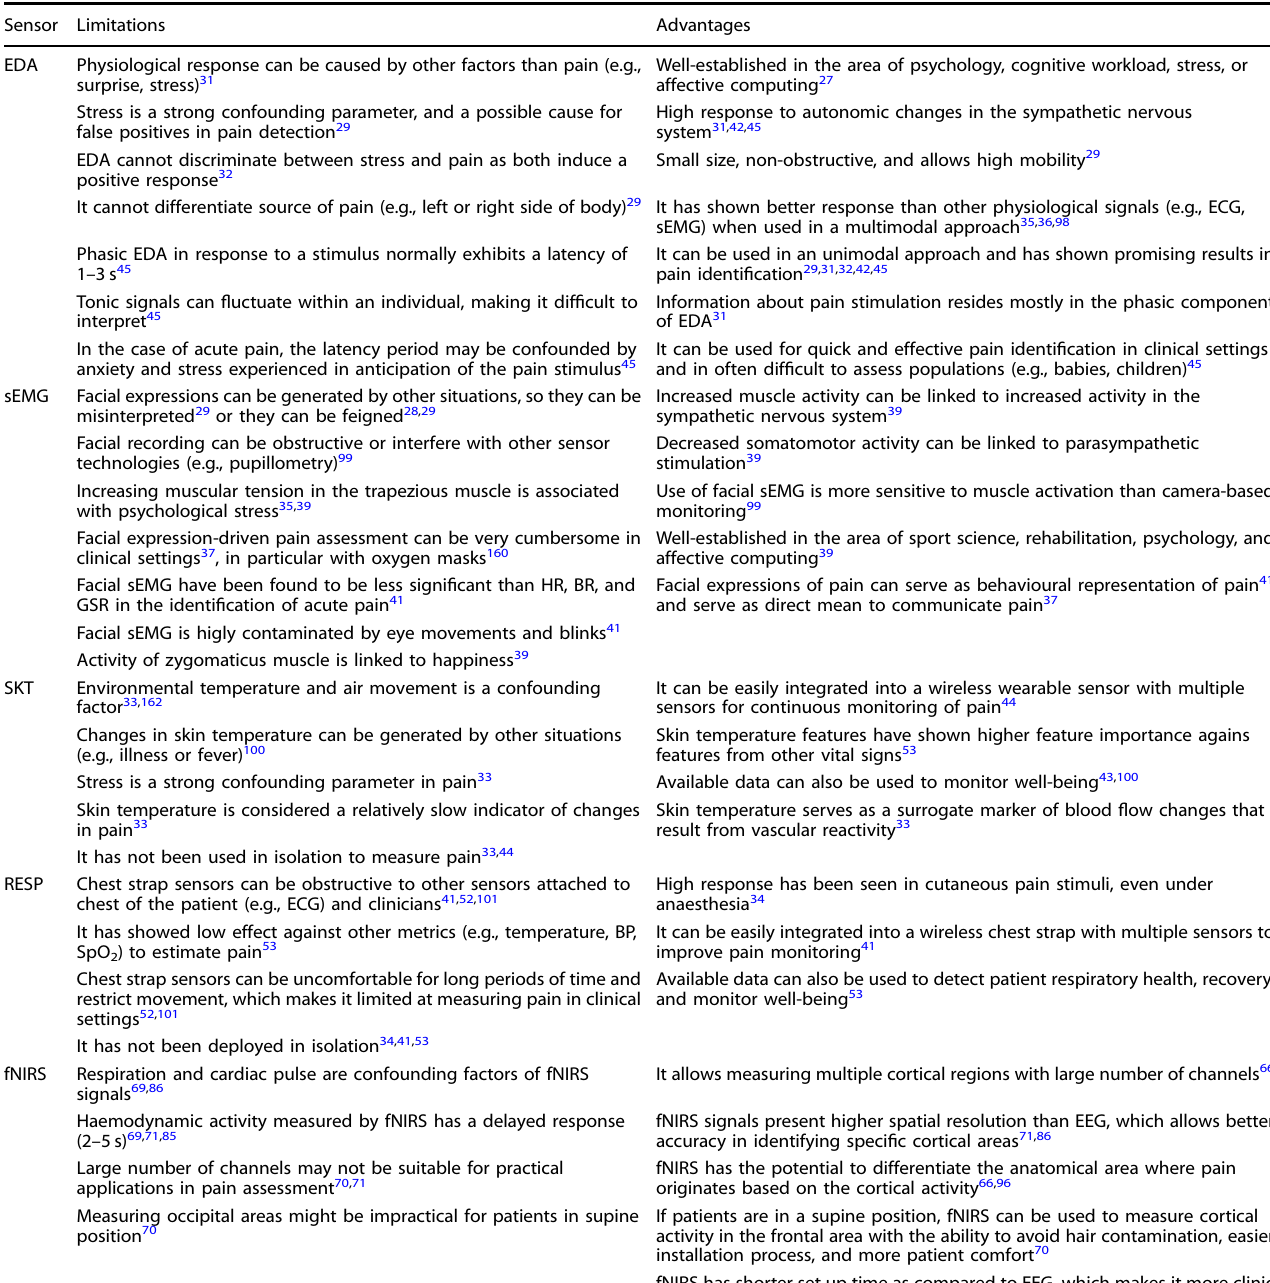
Table 4. Summary of the practical implications from each sensor in their use for the assessment of acute pain as described in the reviewed literature. Sensor